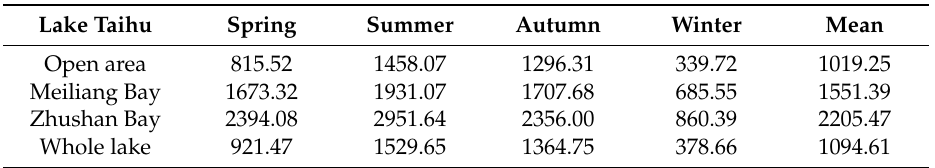
Figure 7. Time series of monthly phytoplankton primary production in Lake Taihu from 2003 to 2013. Table 1. Phytoplankton primary production variations of different seasons in different regions (mg·C·m − 2 ·d − 1 ).